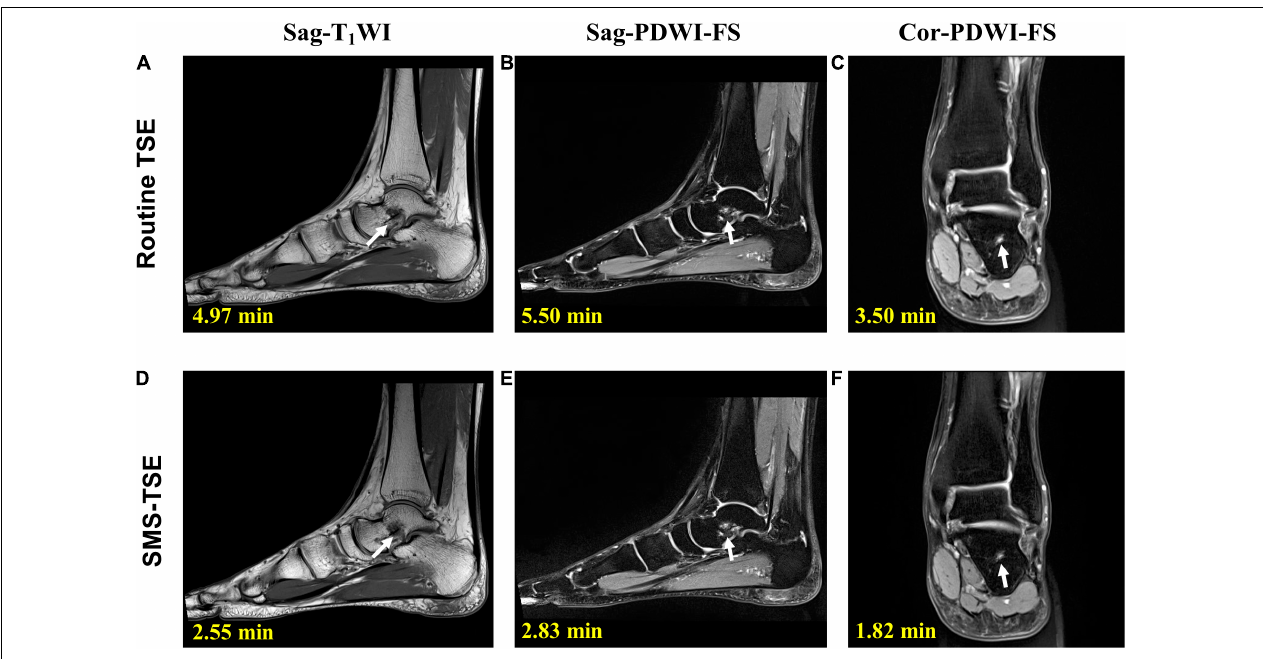
FIGURE 2 | Comparison of the high-resolution turbo spin-echo (TSE) sequence and simultaneous multi-slice-TSE sequence in the ankle joint imaging. On sagittal-proton density-weighted imaging (PDWI)-fat saturation (FS) (B,E) and coronal-PDWI-FS (C,F) images, the bone marrow edema of the talus is clearly depicted (arrow). All the images scored 5 in the image quality evaluation. For routine TSE, the SNR for Sag-T1WI (A) , Sag-PDWI-FS (B) a d Cor-PDWI-FS (C) were 194.79, 143.01, and 158.13; and the CNR for each was 289.83, 125.38, and 147.96. For the SMS-TSE, the SNR for Sag-T1WI (D) , Sag-PDWI-FS (E) a d Cor-PDWI-FS (F) were 187.50, 101.80, and 147.96; and the CNR for each was 196.28, 97.76, and